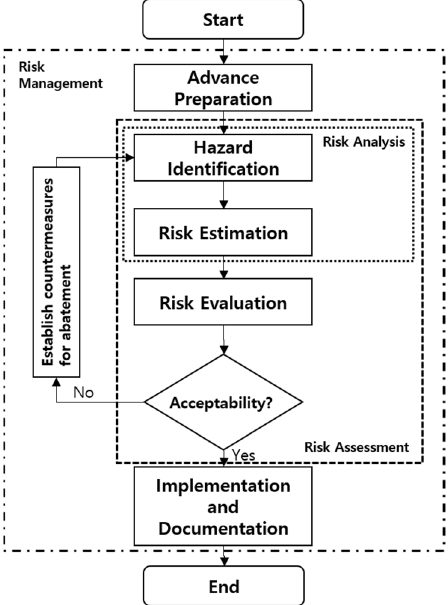
Figure 1. Safety Management Process. 31